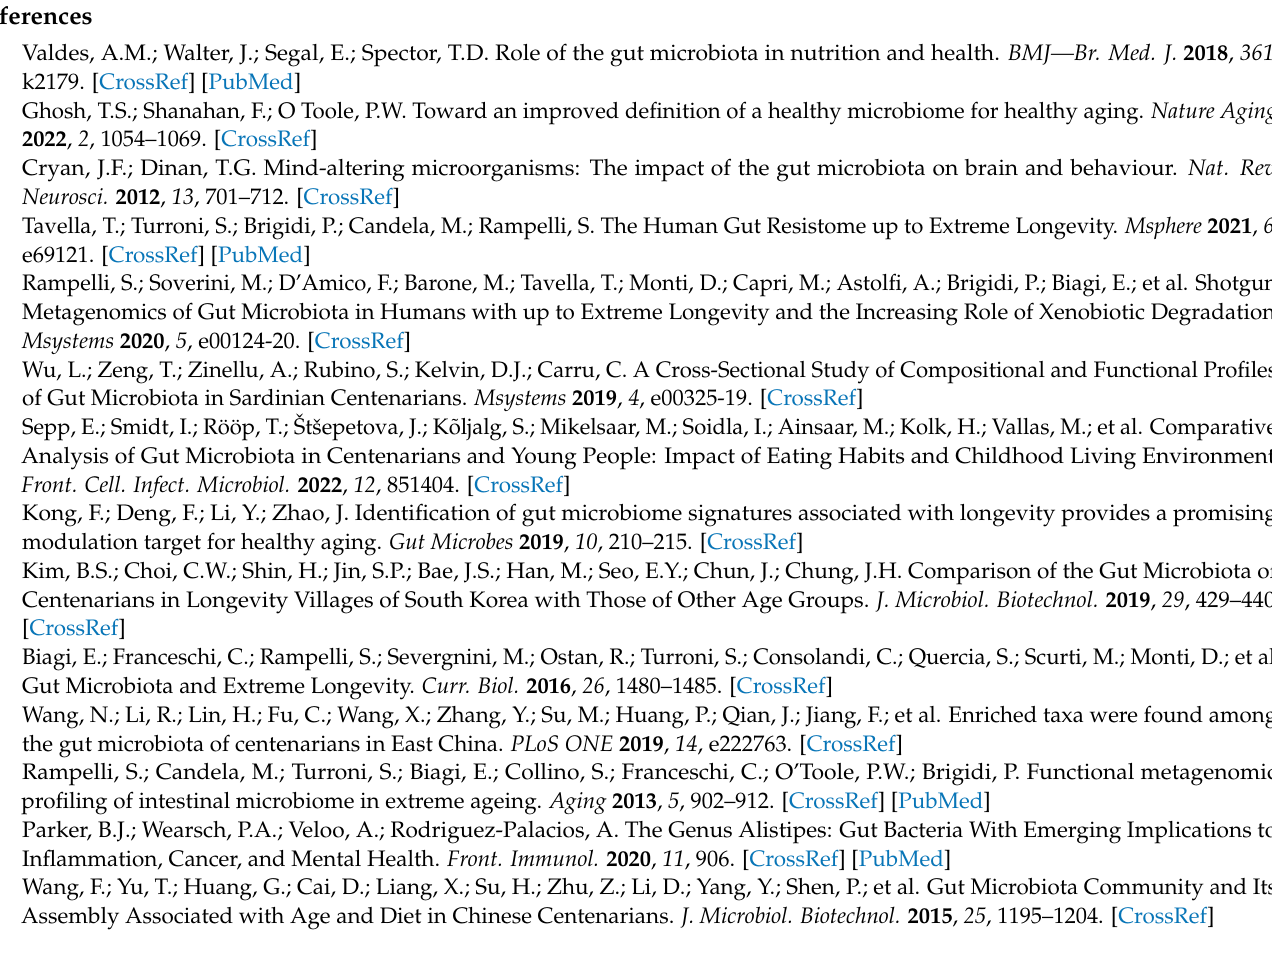
and animal groupings for mice; Figure S2: Structural characteristics of the microbiota; Figure S3: The selection process of a soft threshold; Figure S4: Size of each module; Figure S5: Functional prediction results. Table S1: Details of subjects in each of the categorical groups analyzed in this study; Table S2: Primers and conditions; Table S3: PCR reaction system for strain identification; Table S4: PCR reaction conditions for strain identification. Table S5: Top 10 in the mediumpurple3 network ranked by MNC method. Table S6: Basic characteristics of the